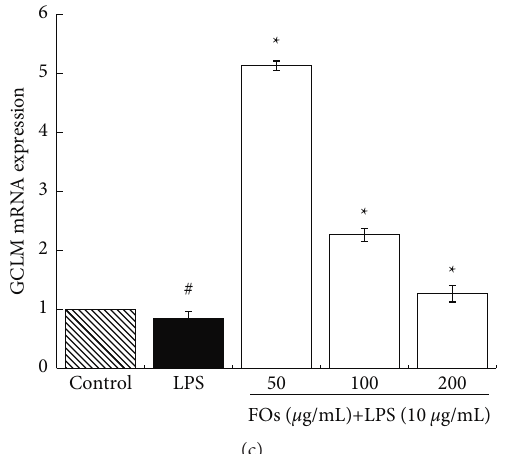
Figure 4: The effects of various concentrations of FOs-FWB on GSH content (a) and GCLC mRNA expression (b) and GCLM mRNA expression (c) of LPS-stimulated IPEC-J2 cells. The data are expressed as the mean ± SE ( n � 3). # Indicates significant differences from control. ∗ Indicates significant differences from LPS. FOs-FWB: feruloyl oligosaccharides from fermented wheat